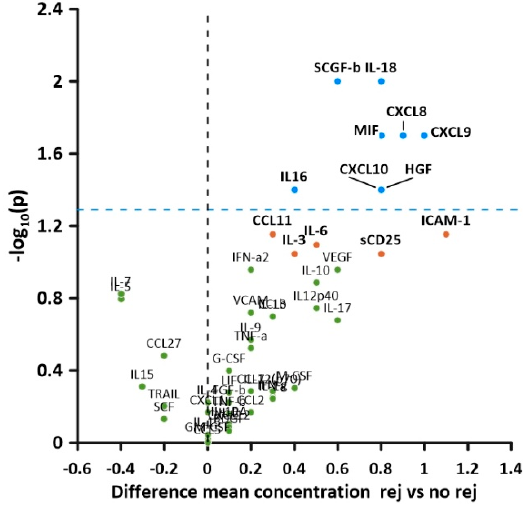
Figure 1. Volcano plot of soluble cytokine levels in patients with and without rejection. The y-axis represents − 1× the logarithmised level of significance, while on the x-axis, the difference between mean concentrations in rejection (rej) and no rejection (no rej) samples is plotted. Cytokines above the blue plotted line had significantly higher values in patients with rejection vs. patients without rejection.